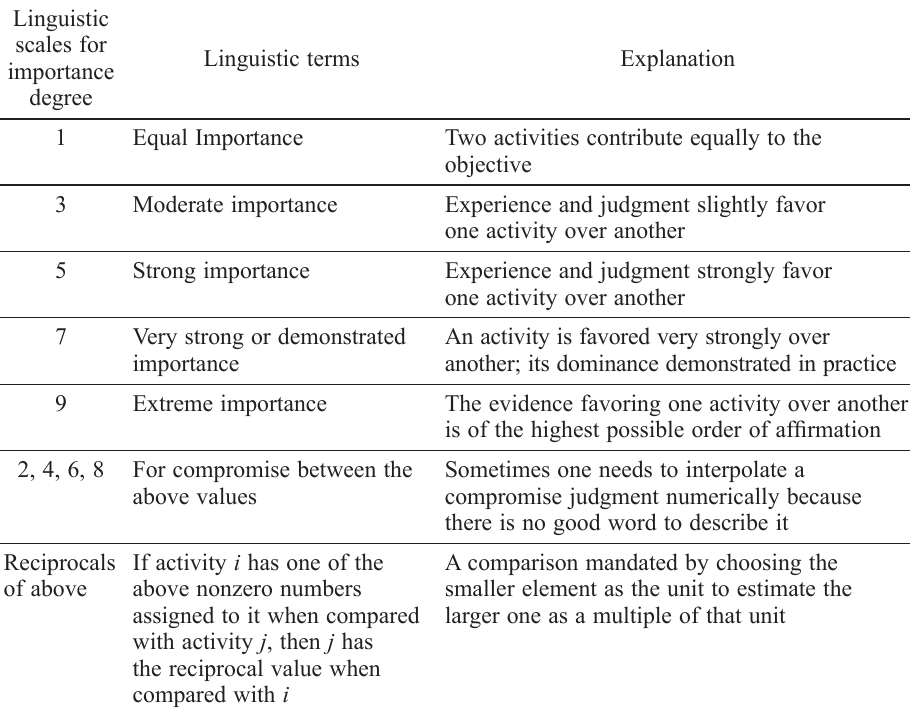
Table 1. Linguistic scales for the importance weight